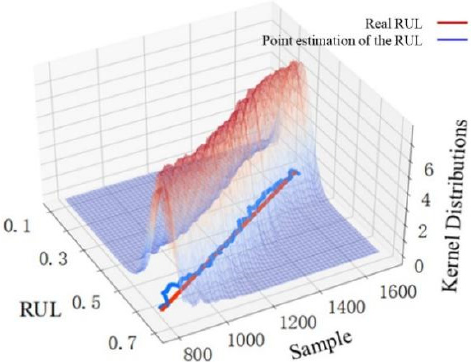
Figure 9. RUL point estimation and nonparametric kernel density distribution in the first stage.